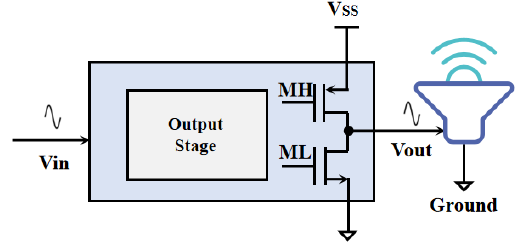
Figure 4. CMOS linear switch output stage.